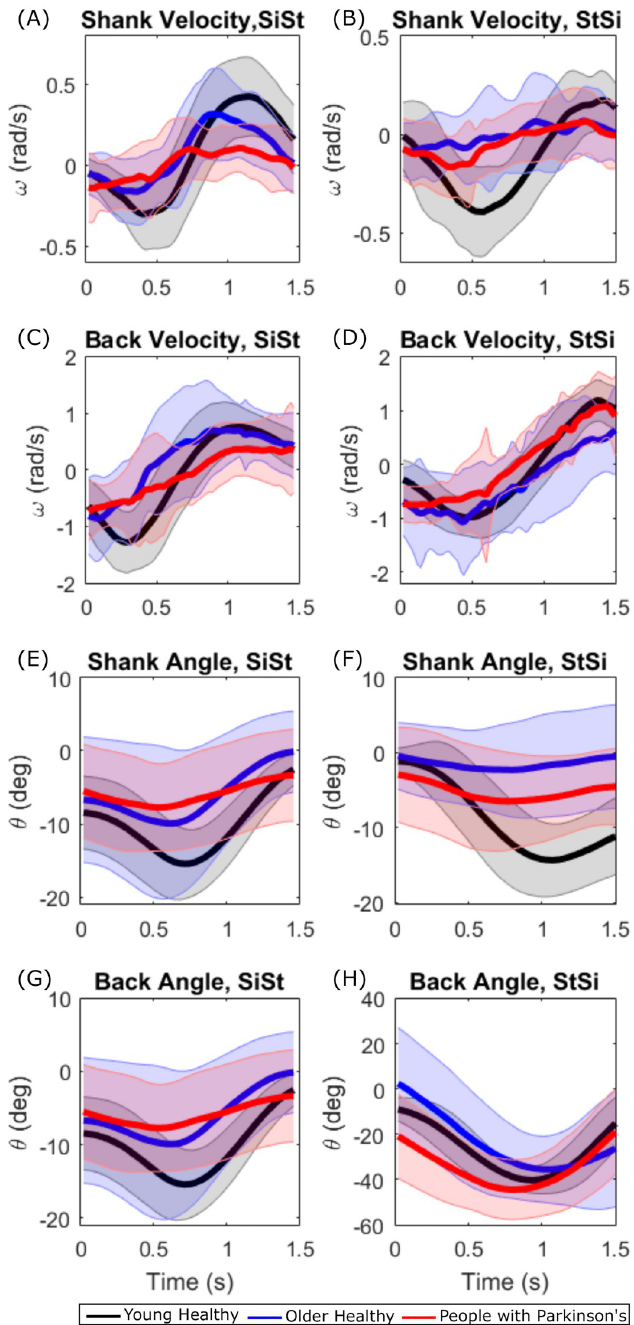
Fig 11. Grand average shank and back velocity and angles during sit-to-stand and stand-to-sit in younger healthy (YH) adults, older healthy (OH) adults and people with Parkinson’s (PwP). (A) Grand average shank velocities in the three participant groups during sit-to-stand. (B) Shank velocities during stand-to-sit. (C) Back velocities during sit- to-stand. (D) Back velocities during stand-to-sit. (E) Shank angles during sit-to-stand. (F) Shank angles during stand- to-sit. (G) Back angles during sit-to-stand. (H) Back angles during stand-to-sit.